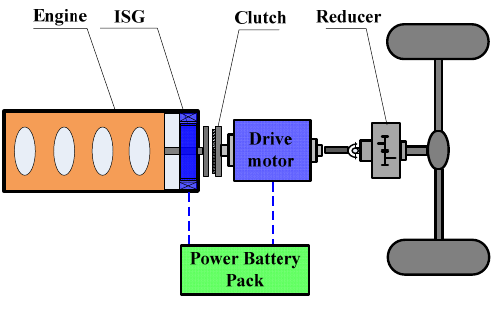
Figure 1. Powertrain architecture. Table 1. Main parameters of the